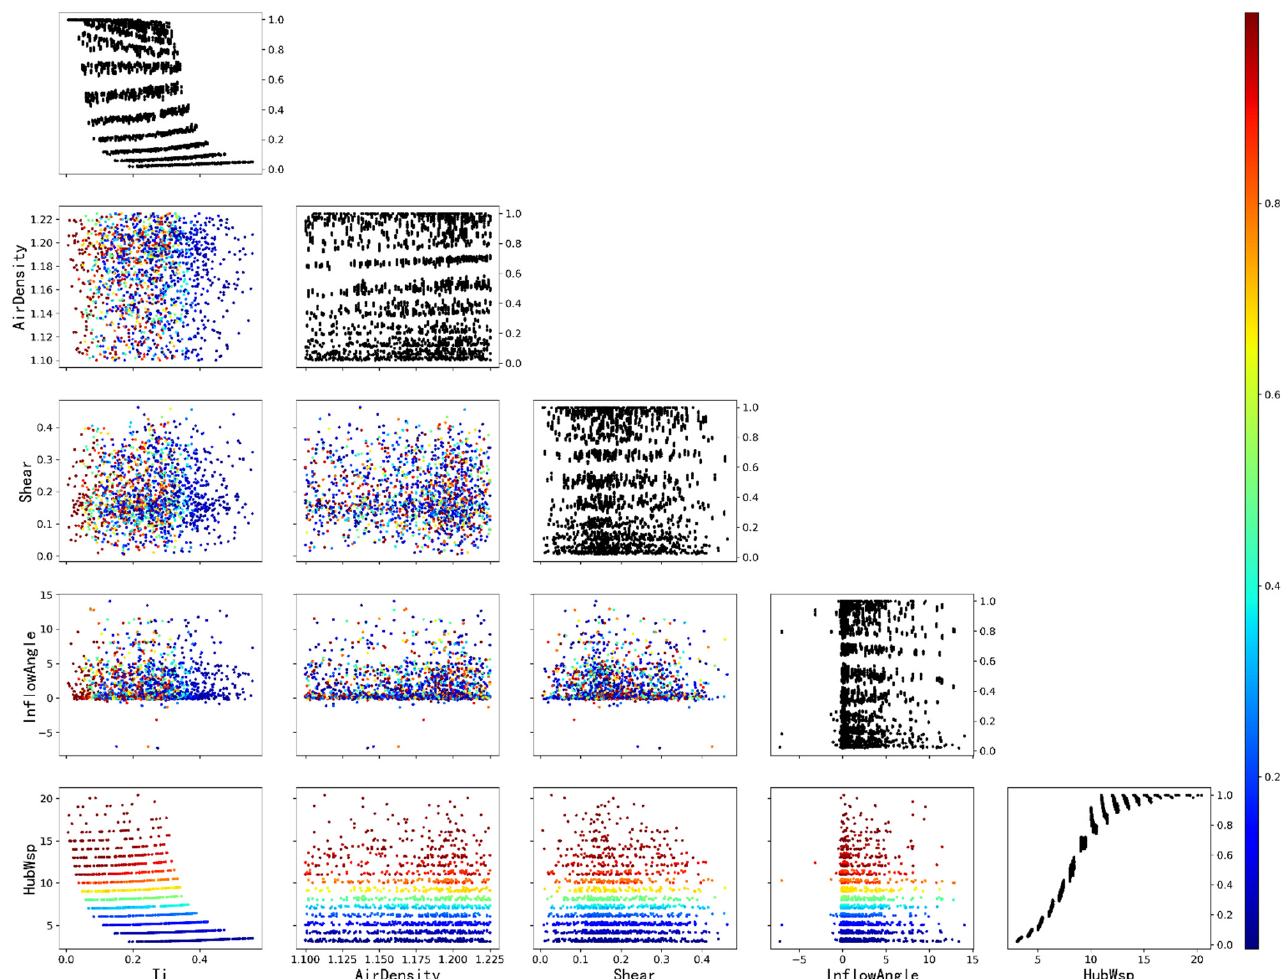
Figure 4. Scatter plot of wind resource parameters from mast data vs. WTG OP, 2D matrix with so-called partial dependence plots of the WTG OP, this shows the influence of each varies from met mast (turbulence intensity, air density, wind shear, and inflow angle) on the WTG OP. The diagonal shows the effect of a single wind resource parameter on the WTG OP, while the plots below the diagonal show the effect on the WTG OP when varying two dimensions (color axis = normalized power at rated power).